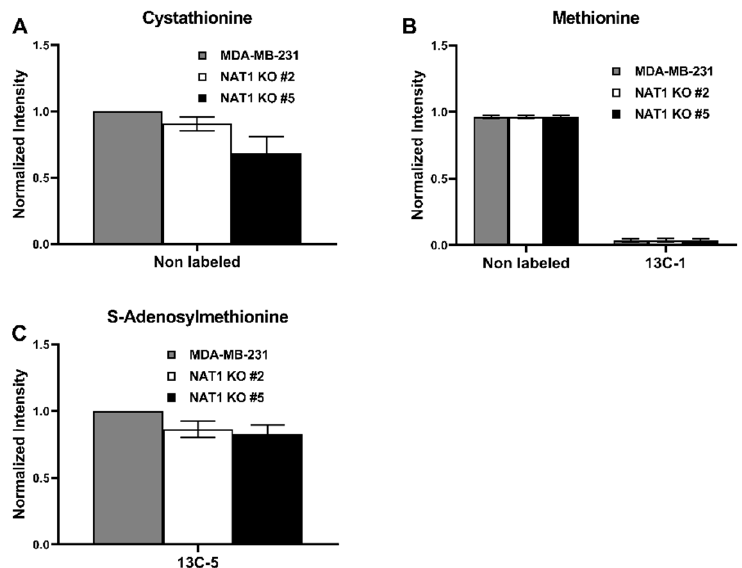
Figure 7. N -Acetyltransferase 1 Knockout Does Not Impact the S-Adenosyl Methionine Cycle Intermediates in MDA-MB-231 Cells. Carbon-13 enrichment of S-Adenosyl Methionine Cycle intermediates were measured in MDA-MB-231 cells and NAT1 KO #2 and #5 after 24 h incubation with [ 13 C]-glucose. Data are presented for both detected unlabeled [ 12 C] and [ 13 C]-labeled metabolites. ( A ) Cystathionine ( B ) Methionine ( 13 C-1) ( C ) S-Adenosylmethionine ( 13 C-5). Data represent the average of at least three experiments ± SEM, no isotopologue has significant abundance changes compared to MDA-MB-231.